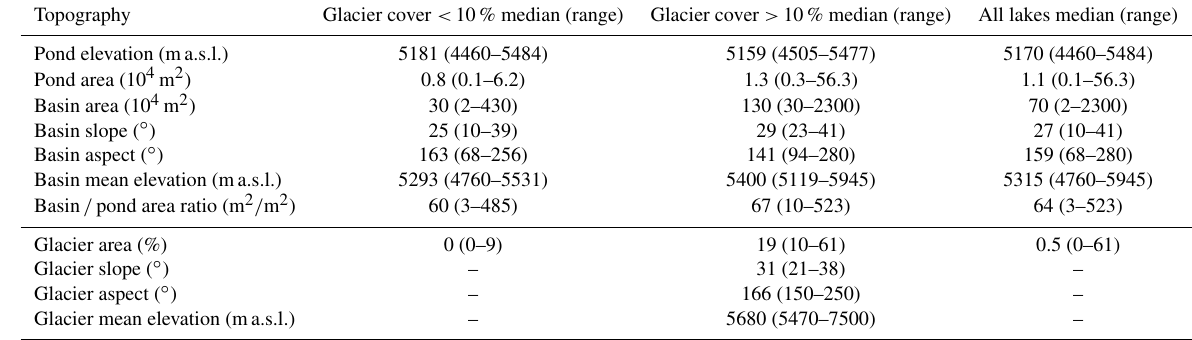
Table 2. General summary of the morphological features of all 64 considered ponds (data from 2013). Ponds are grouped according to the glacier cover present into each pond basin.